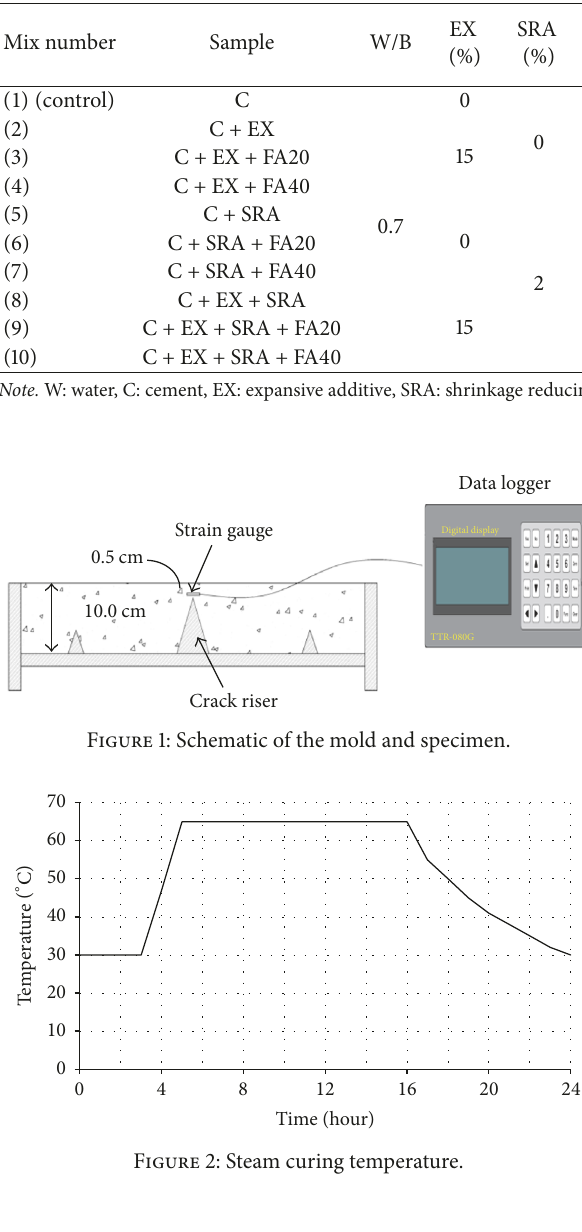
Table 3: Mixture proportions of the mortars.